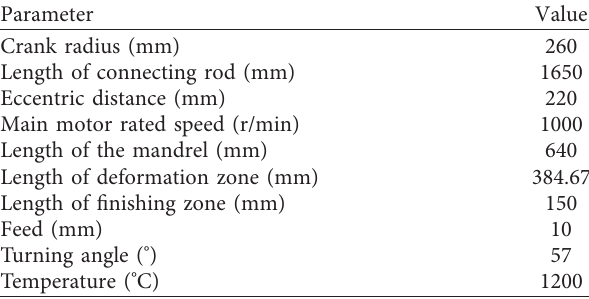
Table 4: The parameters of the LG30 pilger rolling